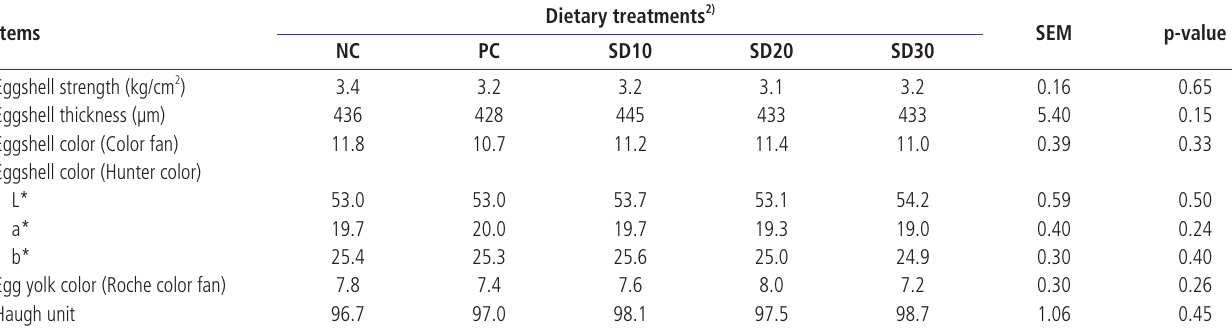
Table 3. Effect of superdosing phytase on egg quality in laying hens